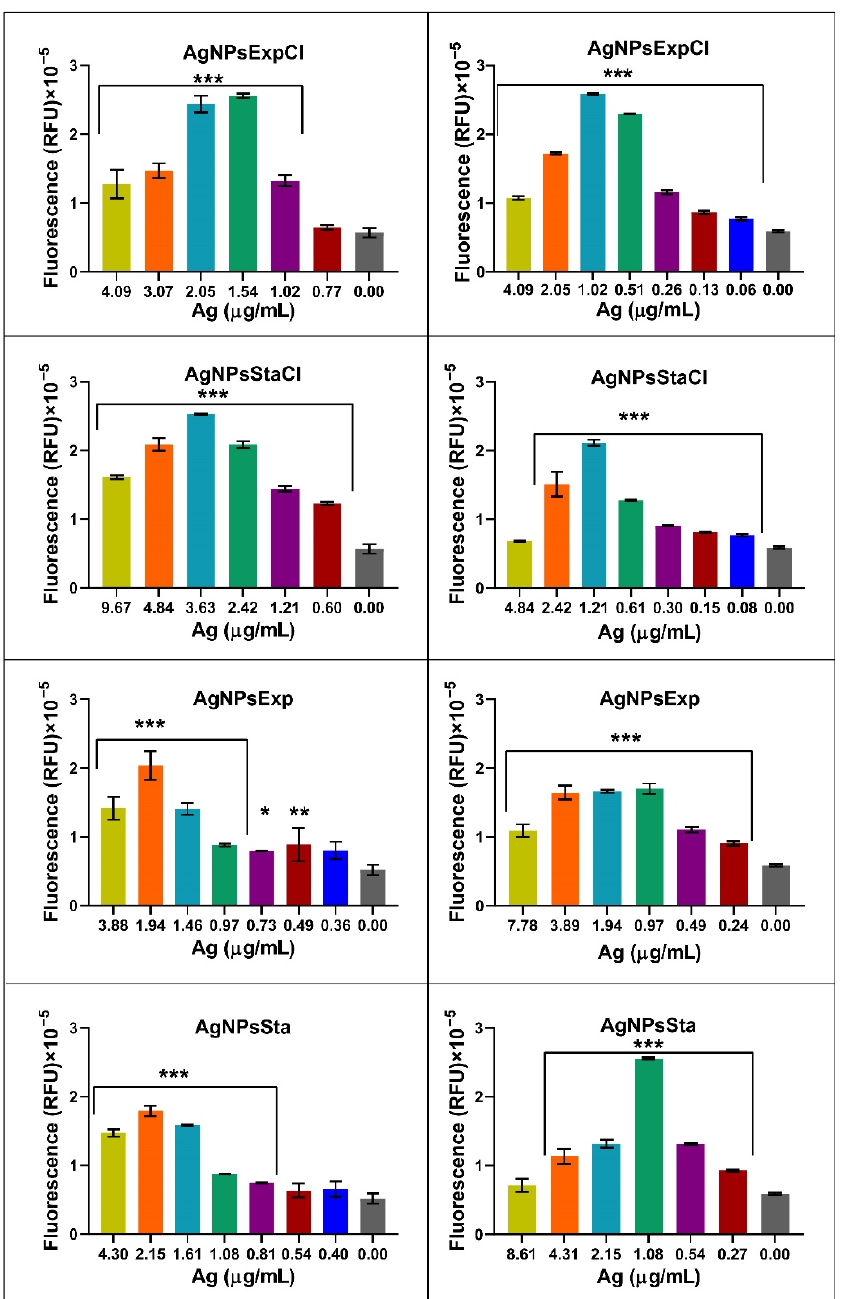
Figure 9. Production of ROS by cultures of E. coli ATCC 25922 ( left panels ) and S. aureus CECT 794 ( right panels ) after 6 h of incubation with AgNPs. RFU: relative fluorescence units. p -value: <0.05 (*), <0.01 (**), and <0.001 (***).